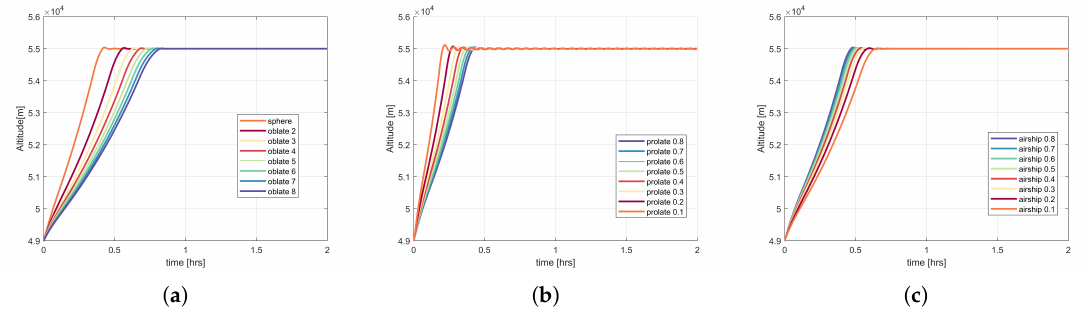
Figure 6. Altitude variation of the SP balloons for different shapes with varying fineness ratio f in order to find the stable fineness ratio on Venus ( a ) oblate ( f : 2–8) ( b ) prolate (0.1–0.8) ( c ) airship (0.1–0.8).